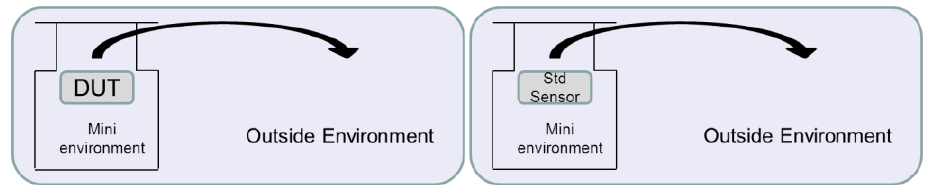
Figure 15. Schematic recovery time test procedure.